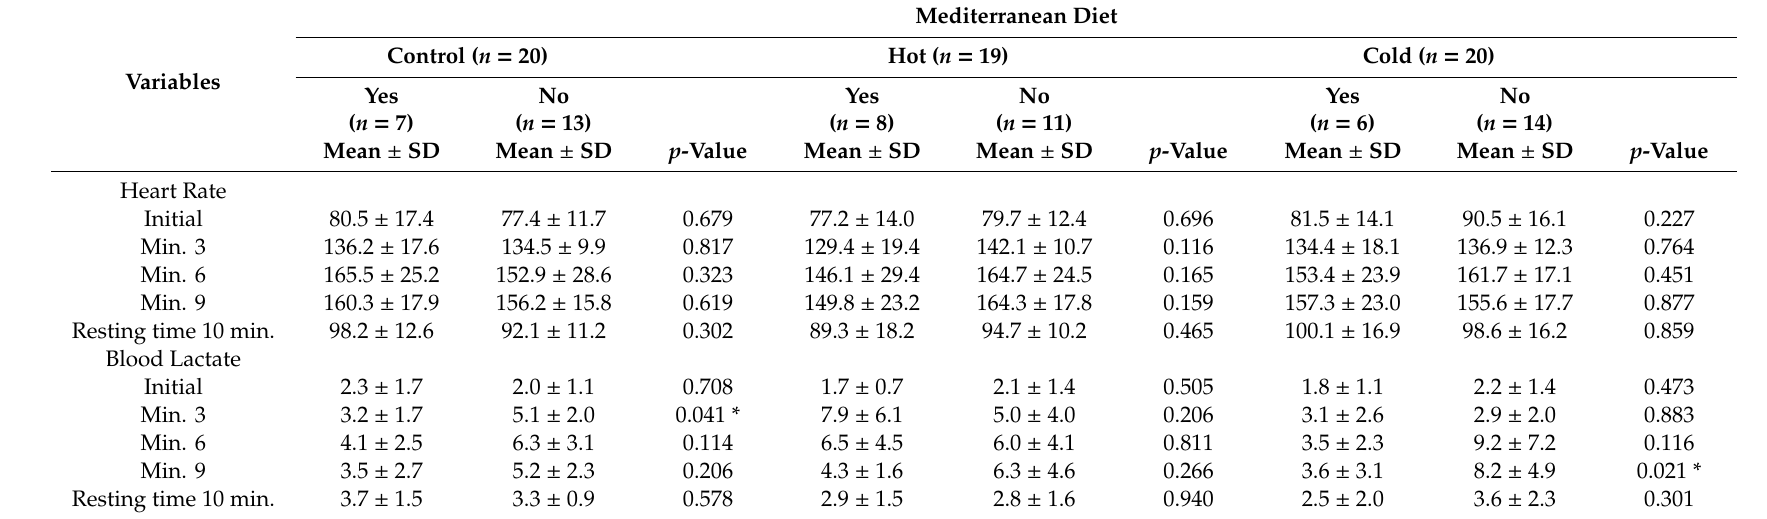
Table A1. Physiological parameters (heart rate and blood lactate) based on the adherence to a Mediterranean diet, considering the environmental conditions.